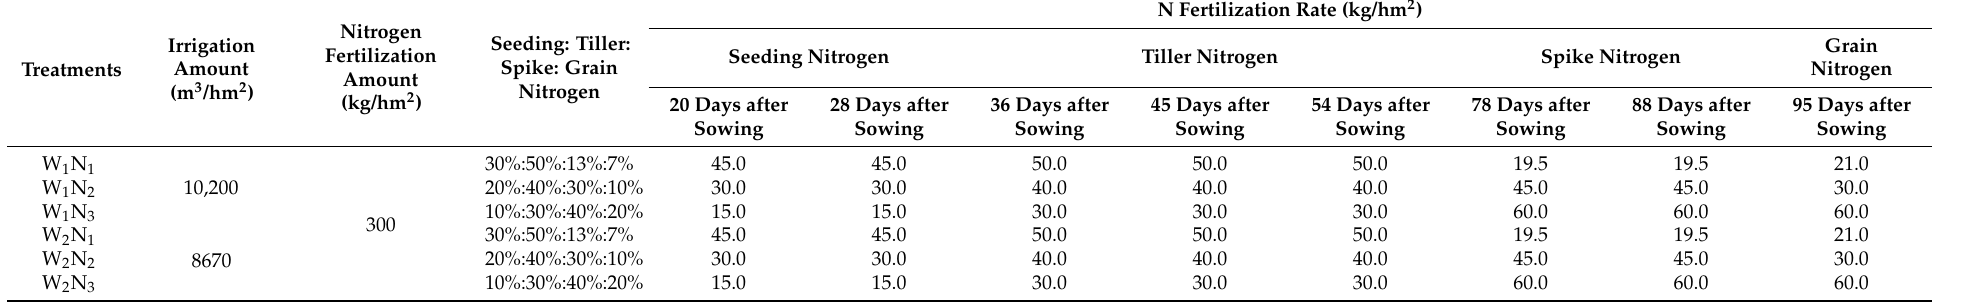
Table 2. N rate for drip irrigation rice under plastic film